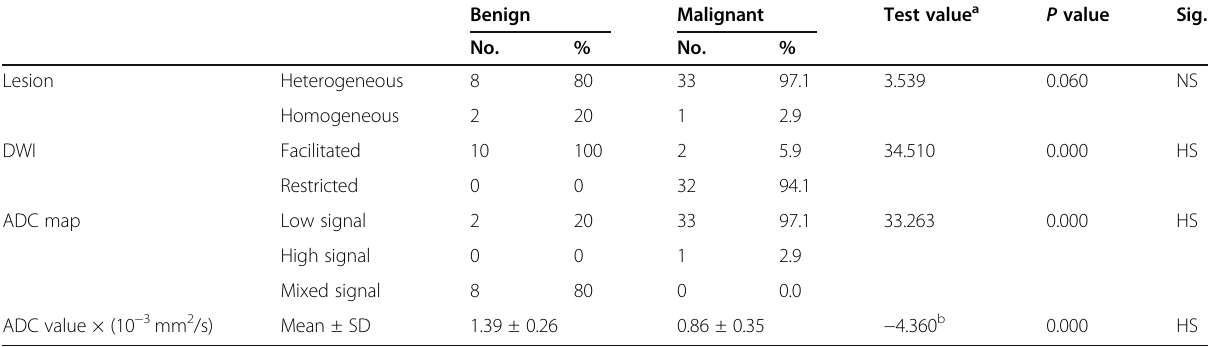
Table 5 Comparison between benign and malignant tumors regarding signal homogeneity or heterogeneity, DWI, ADC map, and ADC value